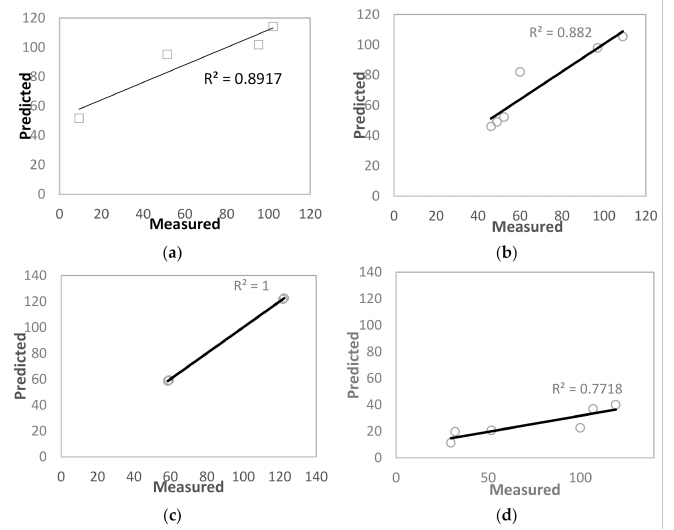
Figure 15. Measured against predicted of the waterless trap seal (Sample 3) dominant opening frequencies. Predicted data is derived from Equation (19). Figure 15 ( a ) threshold, ( b ) low, ( c) medium and ( d )